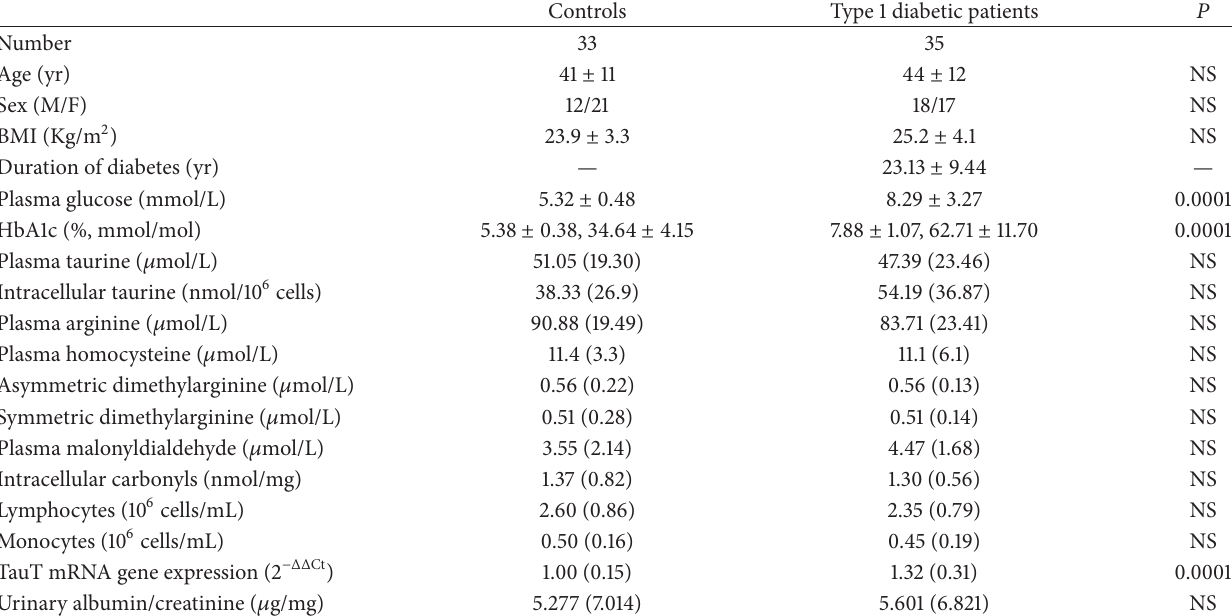
Table 1: Main characteristics of diabetic patients and control subjects.